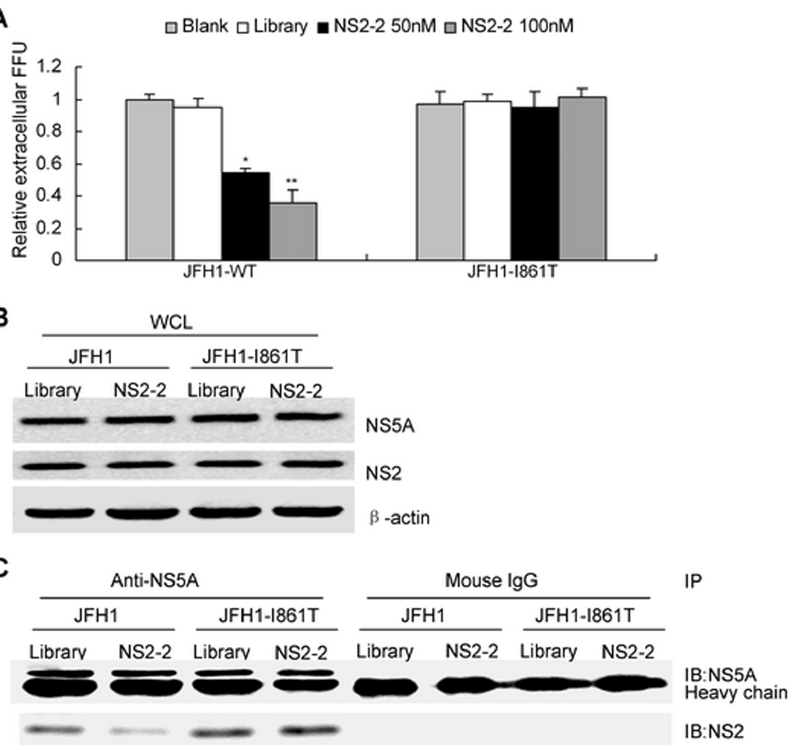
Figure 7. I861T substitution in NS2 is the major selective resistance mutation identified. ( A ) Selection of resistance-conferring mutations was performed. Huh7.5 cells were infected with media from Huh7.5 cells transfected with RNA from wild type (WT) or selected I861T viral clone. The effect of aptamer NS2-2 on the production of infectious WT or selected I861T mutated virus particles was tested as described in Figure 3D. Results are the average of three independent experiments. * P , 0.05, ** P , 0.01 verse control cells. ( B ) I861T mutation had no effect on viral protein expression. Huh7.5 cells were infected with media from Huh7.5 cells transfected with RNA from wild type (WT) or selected I861T viral clone, followed with NS2- specific aptamer treatment for 72 hours. Protein was isolated and NS2 or NS5A was detected by western blot analysis. ( C ) I861T mutation escaped the disruption of NS2-2 aptamer on the interaction of NS2 with NS5A. Huh7.5 cells were treated as described in part B. Protein was isolated from the HCV-infected Huh7.5 cells with aptamer or library treatment and immunoprecipitated with antibodies against NS5A or mouse IgG conjugated with agarose beads respectively. The protein binding to the beads were boiled and subjected to SDS-PAGE. The protein was transferred onto PVDF membrane and then reacted with mouse monoclonal anti-NS2 or NS5A antibody and secondary